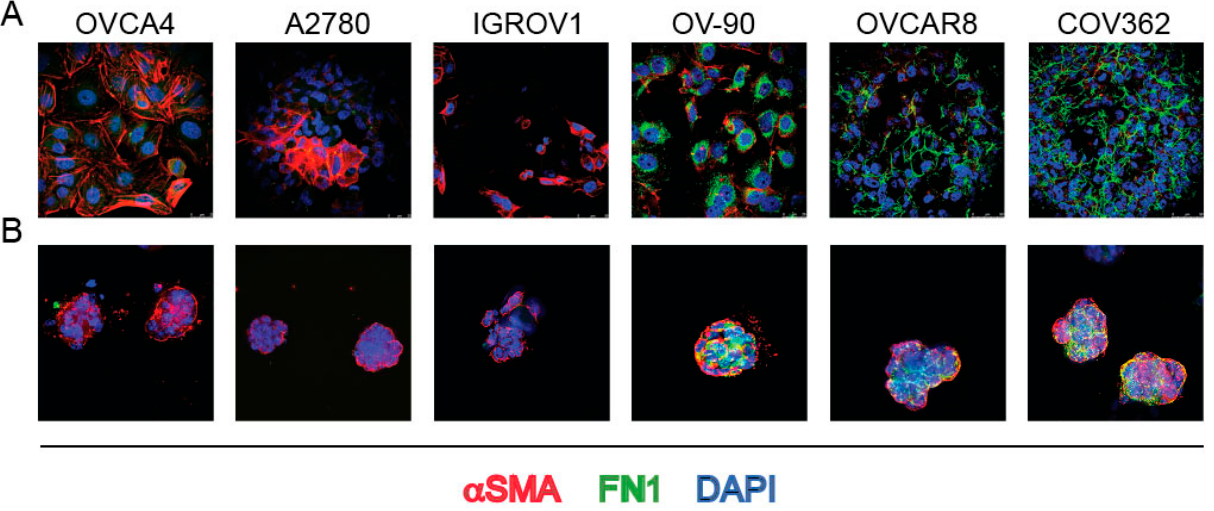
Figure 9. IF staining of the indicated ovarian cancer cell lines with DAPI and α SMA and FN1 MAbs (merged) either grown as monolayer cultures ( A ) or forming 3D aggregates in Matrigel ( B ). Using Ingenuity Pathway Analysis [31] we ascertained that the proline-rich tyrosine kinase 2 (PTK2B/PYK2), which belongs to the family of FAK kinase, regulates the ex- pression of both α SMA and FN1. This is in accordance with previous reports showing the up-regulation of α SMA by this kinase (see e.g., [32]). Less known is the role of